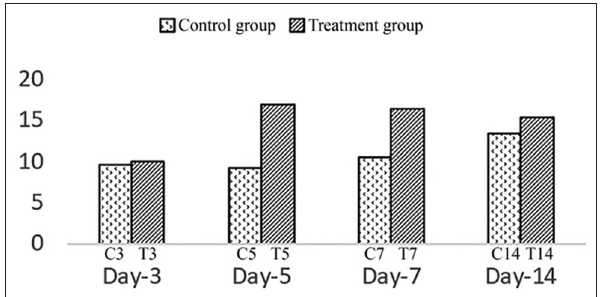
Figure-1: The MAC387 expression in control groups and treatment groups on day 3, 5, 7, and 14.